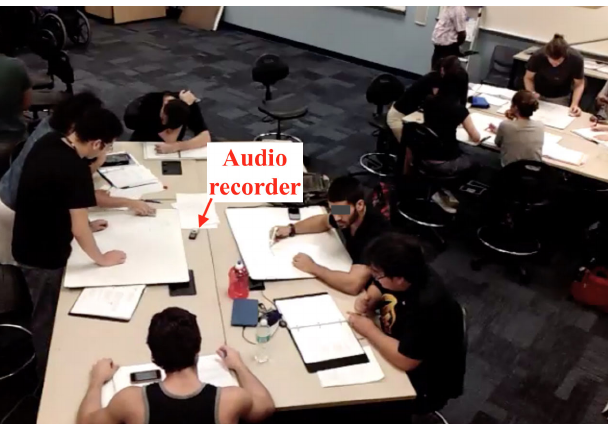
FIG. 1. A view of the setup of one table, as viewed from the video